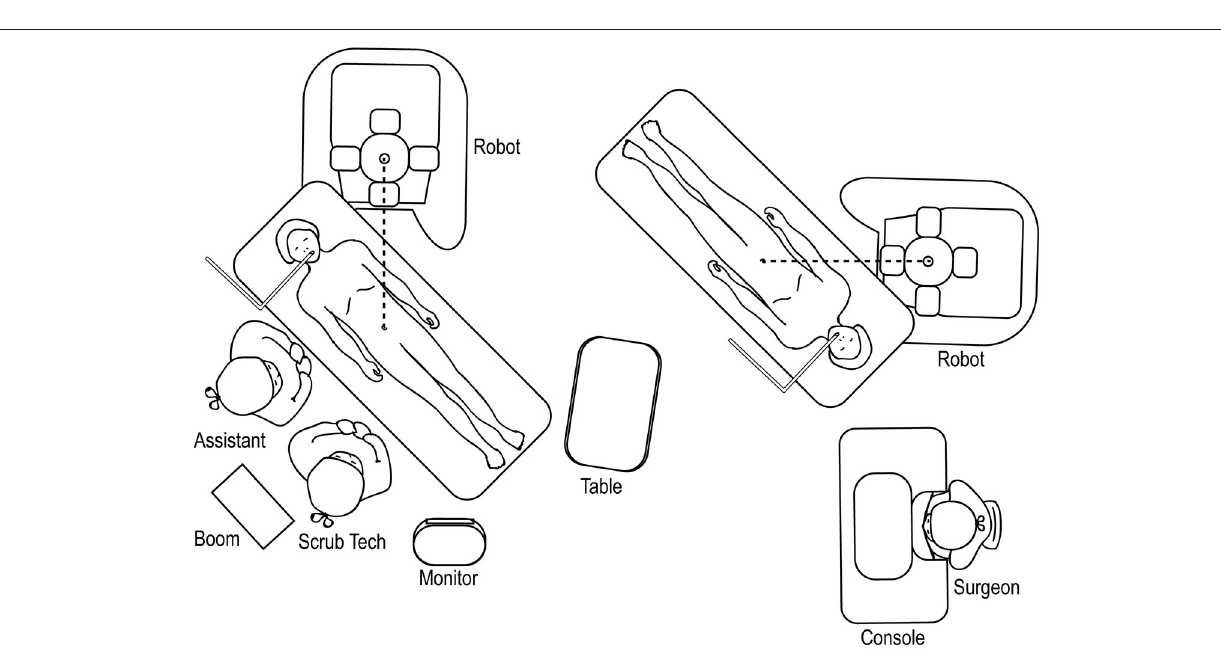
Frontiers in Pediatrics |